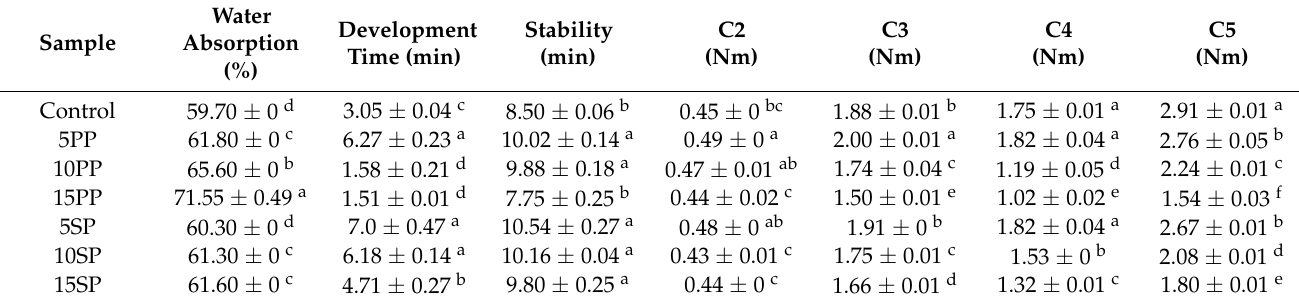
Table 3. Mixolab rheological parameters of wheat flour and wheat flour–protein concentrate blends.